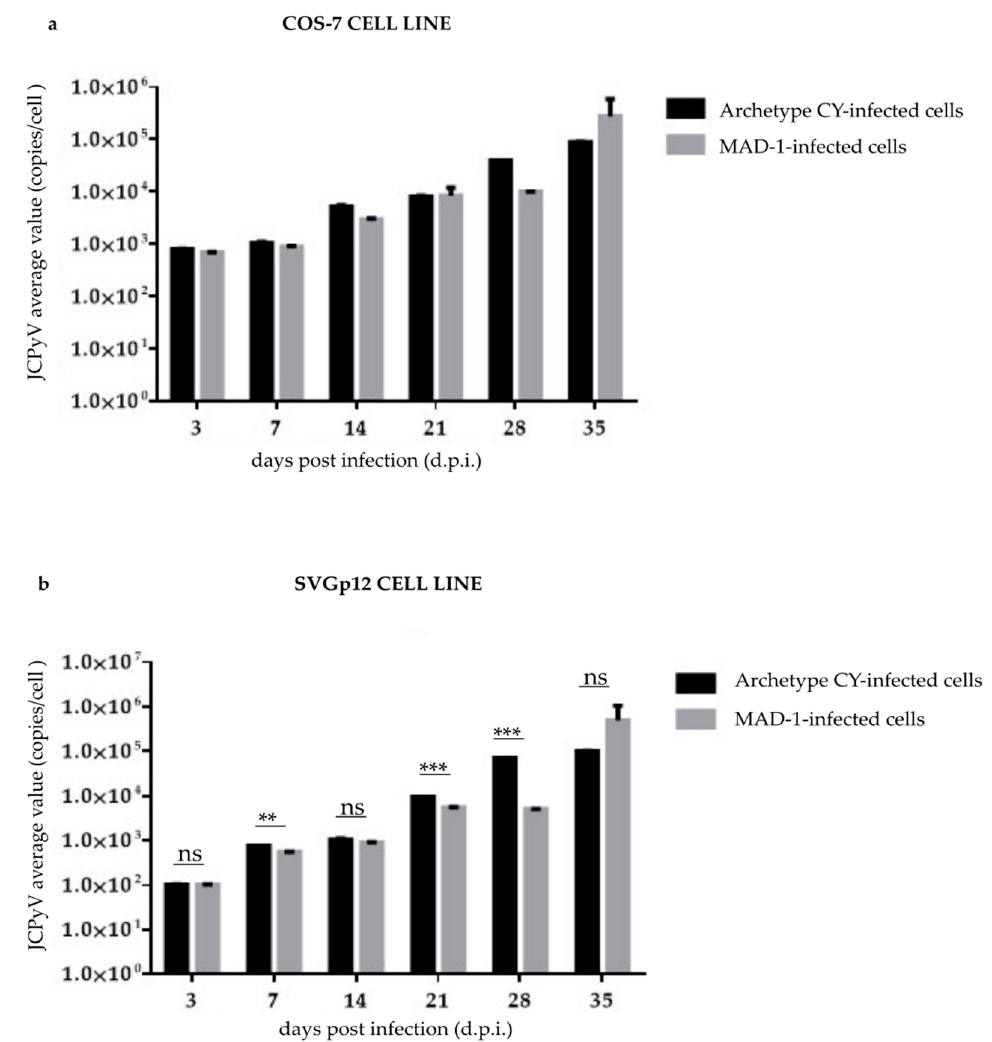
Figure 4. JCPyV replication in the CY- and MAD-1-infected COS-7 and SVGp12 cell lines after the addition of JCPyV-miRNA-5p exosome preparations to uninfected cells: ( a ) Viral replication into the COS-7 cell line at selected sampling times after infection, from 3 d.p.i until 35 d.p.i., was quantified by qPCR. Data are expressed as the mean of three independent experiments, and error bars indicate standard deviations; ns: not significant. ( b ) Viral replication into the SVGp12 cell line at selected sampling times after infection, from 3 d.p.i until 35 d.p.i., was quantified by qPCR. Data are expressed as the mean of three independent experiments, and error bars indicate standard deviations; ns: not significant; ** p < 0.01; *** p < 0.001.